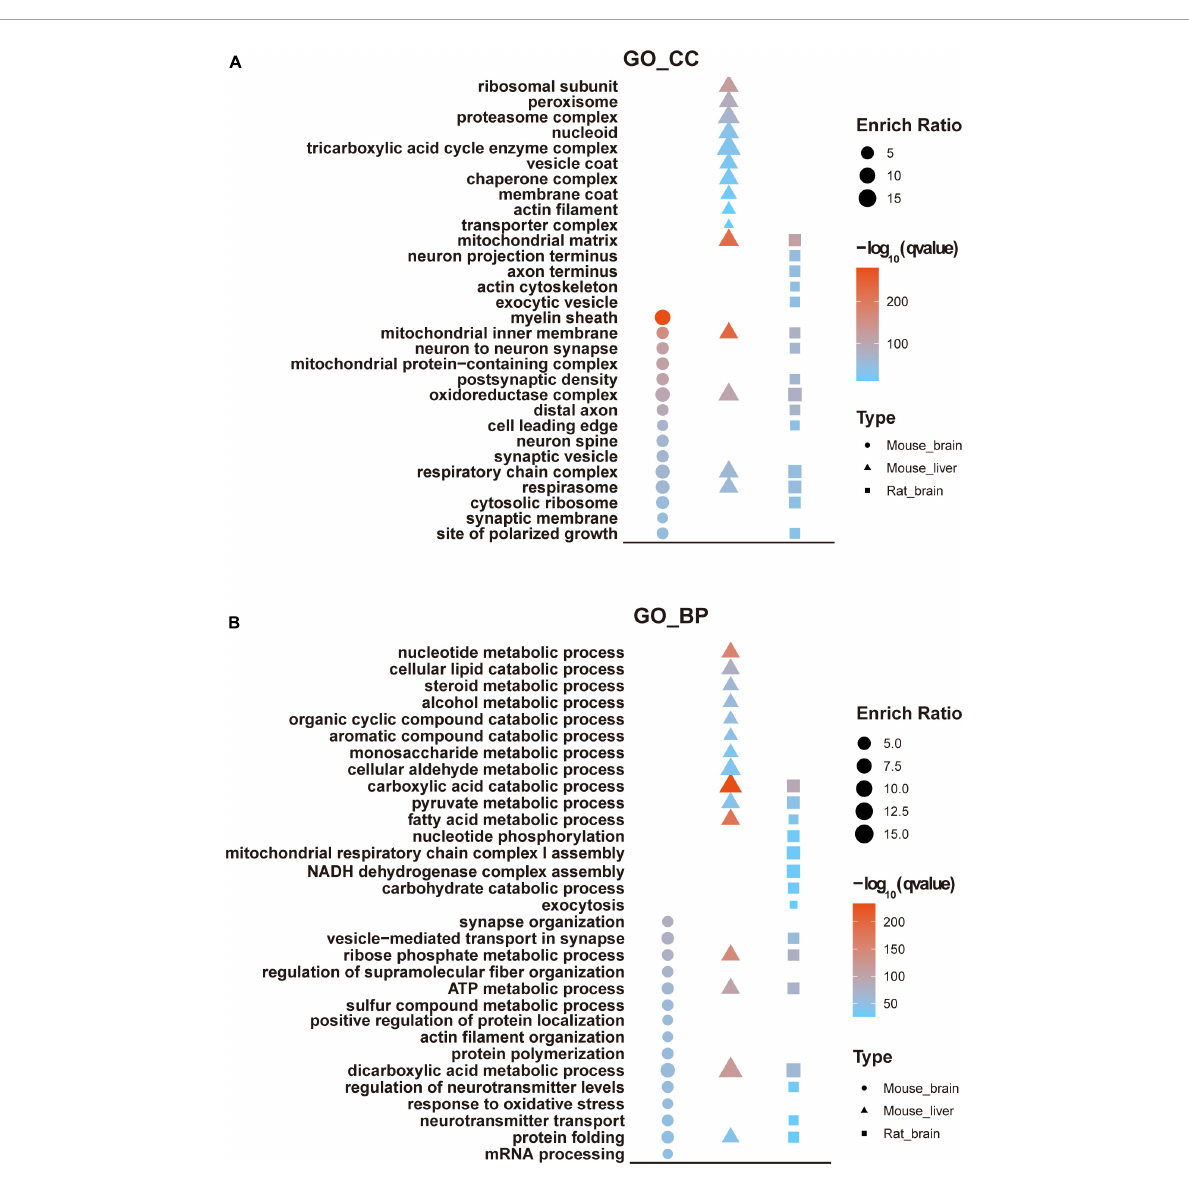
were identified ( Table 1 and Supplementary Table 3